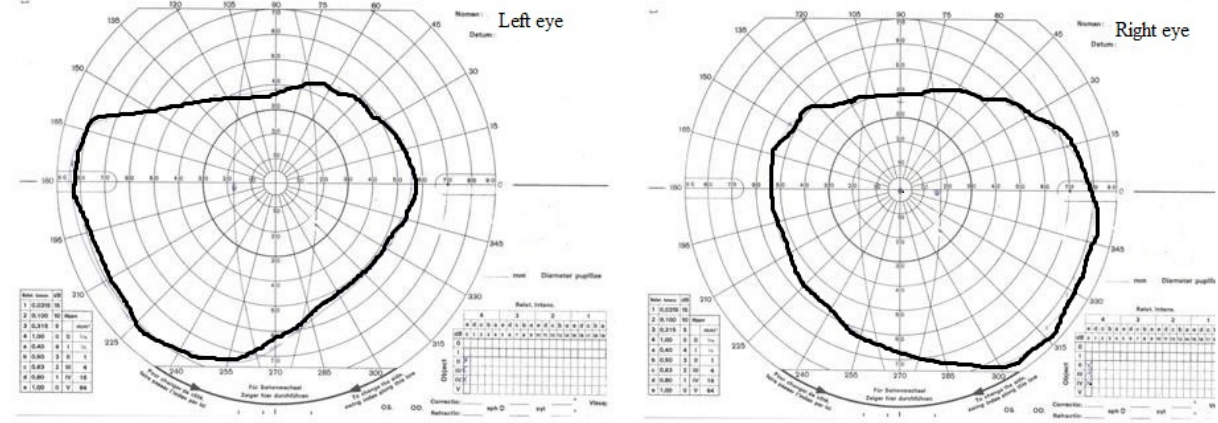
Figure 3. The eldest child. Kinetic visual field examination (August). A small central scotoma in the right-eye visual field.